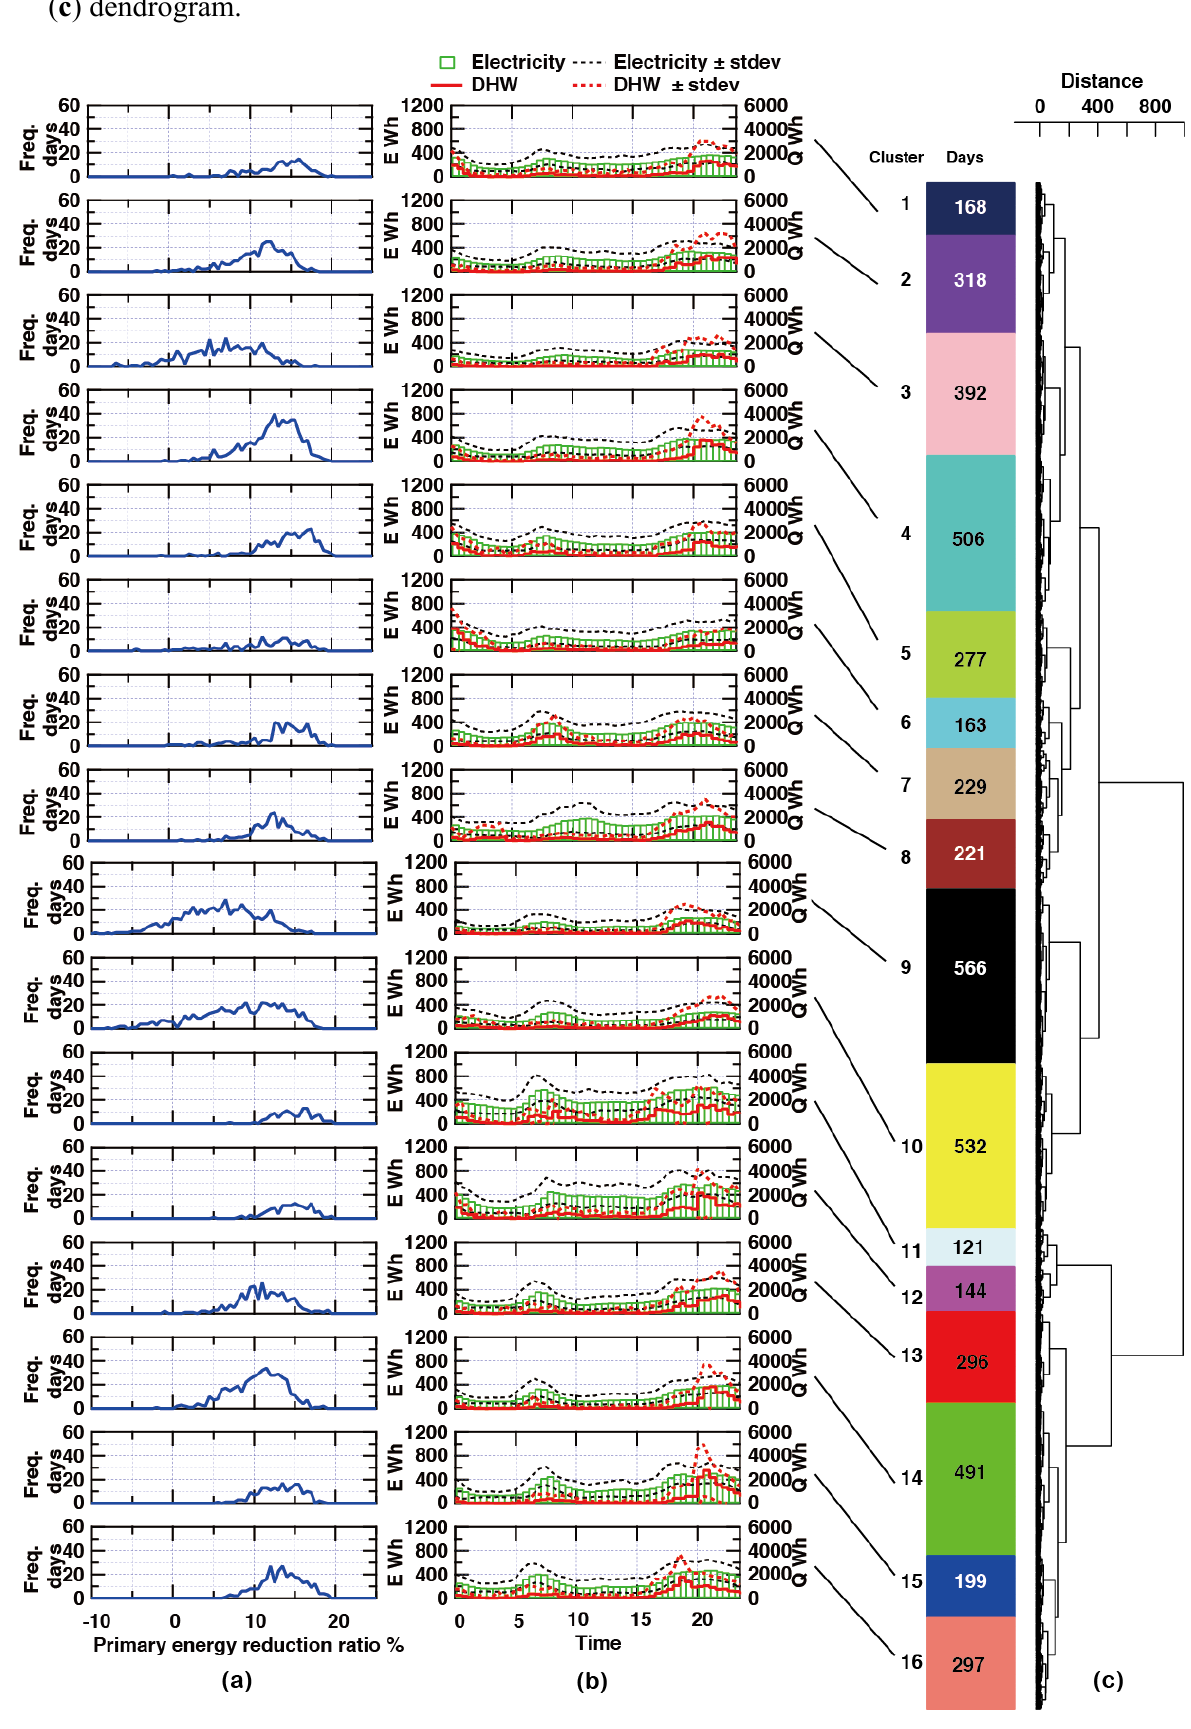
Figure 11. Clusters in Group D. ( a ) primary energy reduction ratio; ( b ) demand patterns; ( c )